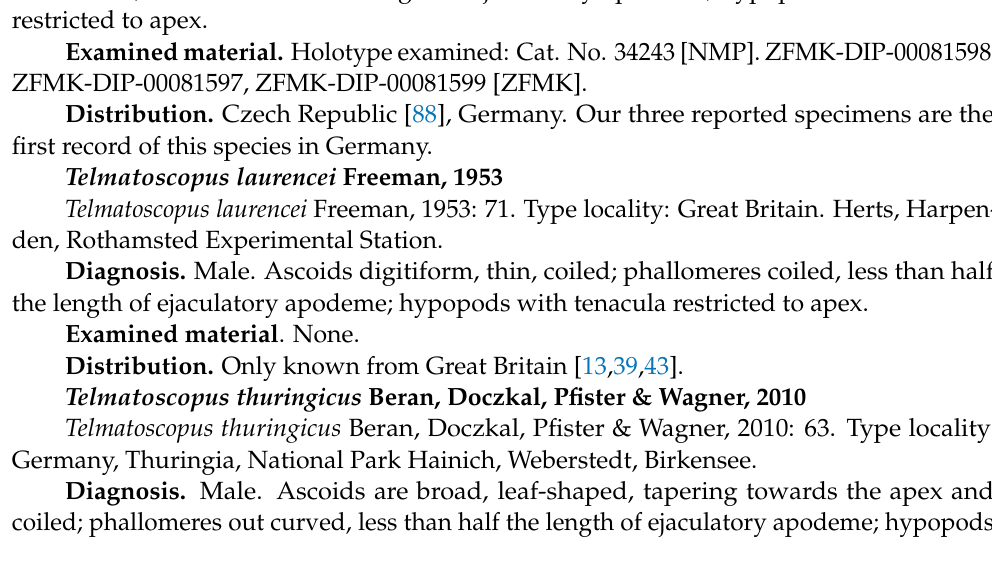
Krivosheinoscopus bartai Ježek, 2004: 117, Type locality: Czech Republic: Bohemia or., Železn é hory Mts Protected landscape area. Diagnosis. Male. Ascoids digitiform, thin, long, and coiled; phallomeres symmetrical, out curved, more than half the length of ejaculatory apodeme; hypopods with tenacula restricted to